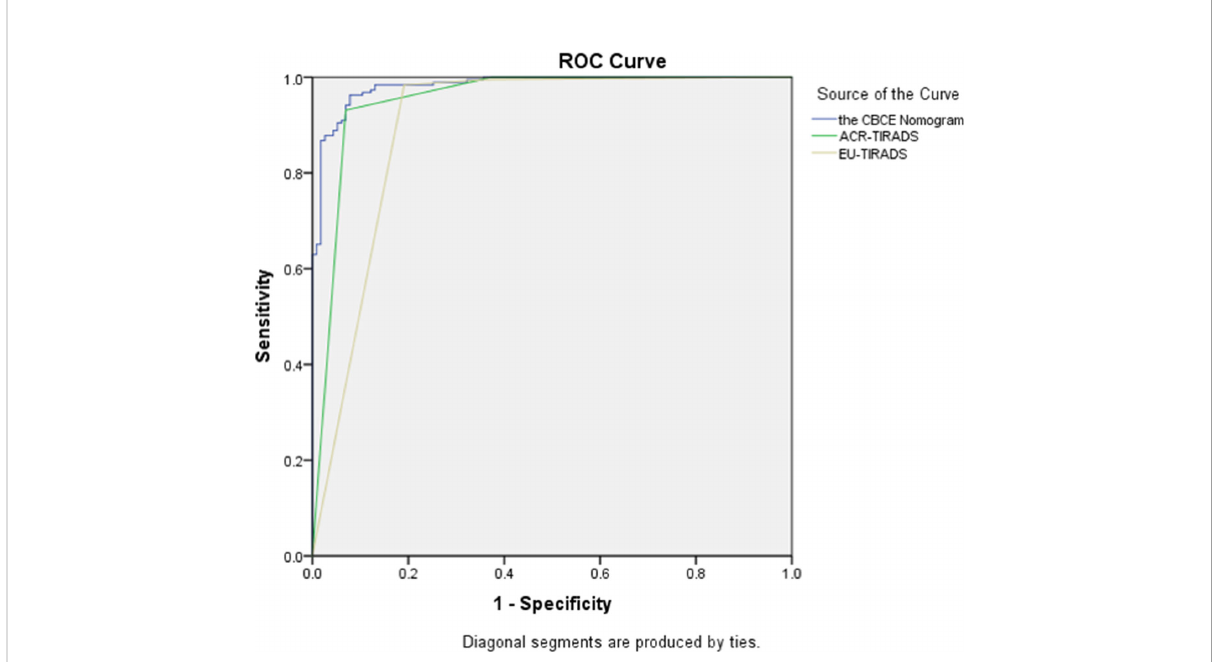
FIGURE 5 The comparison of Receiver operating characteristic curves among the CBCE nomogram, ACR-TIRADS and EU-TIRADS based on the validation group. The area under the curves for the three models were 0.983 (0.971, 0.994), 0.948 (0.918, 0.978) and 0.889 (0.844, 0.934),